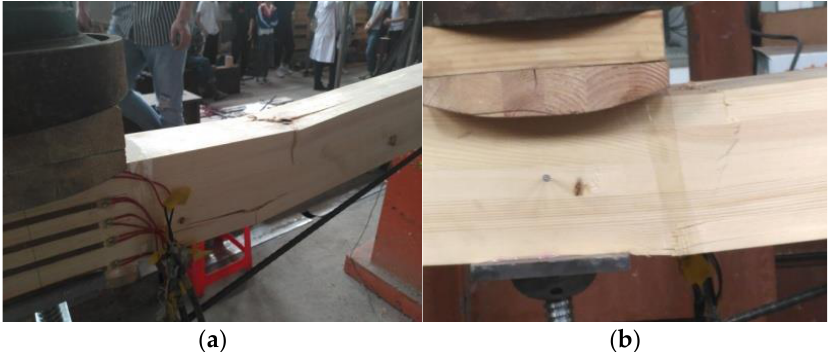
Figure 13. Failure mode of L A1 . ( a ) Tensile failure of left span; ( b ) Tensile failure of right span.